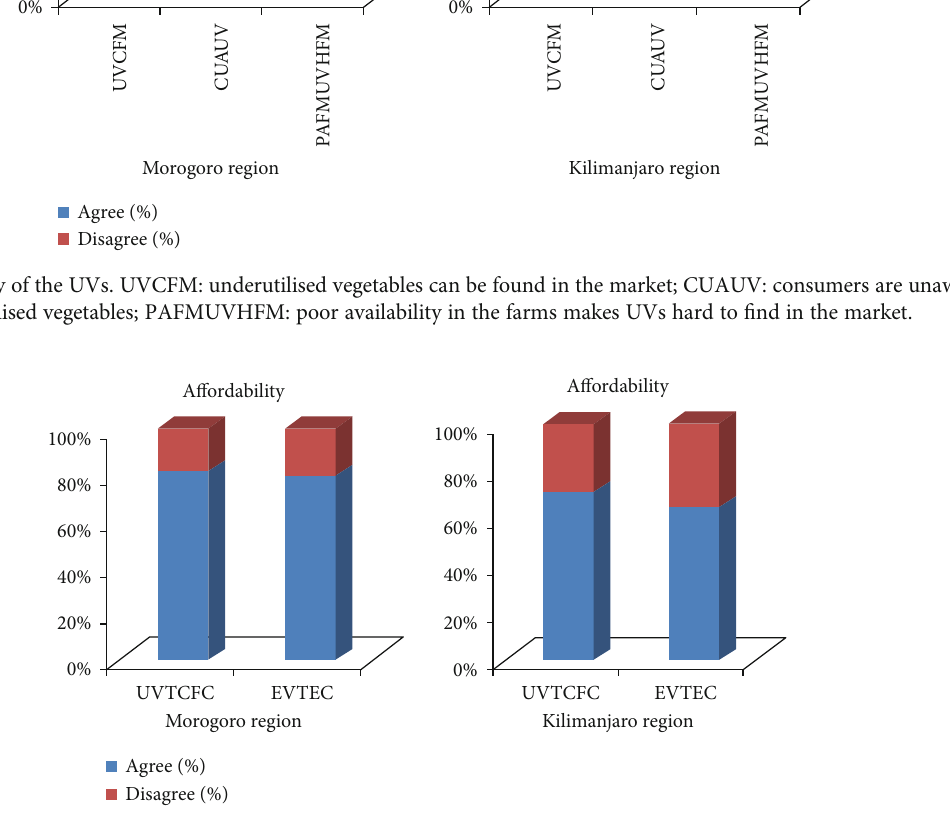
Figure 8: A ff ordability of the UVs. UVTCFC; underutilised vegetables are too cheap for consumers; EVTEC; exotic vegetables are too expensive for some